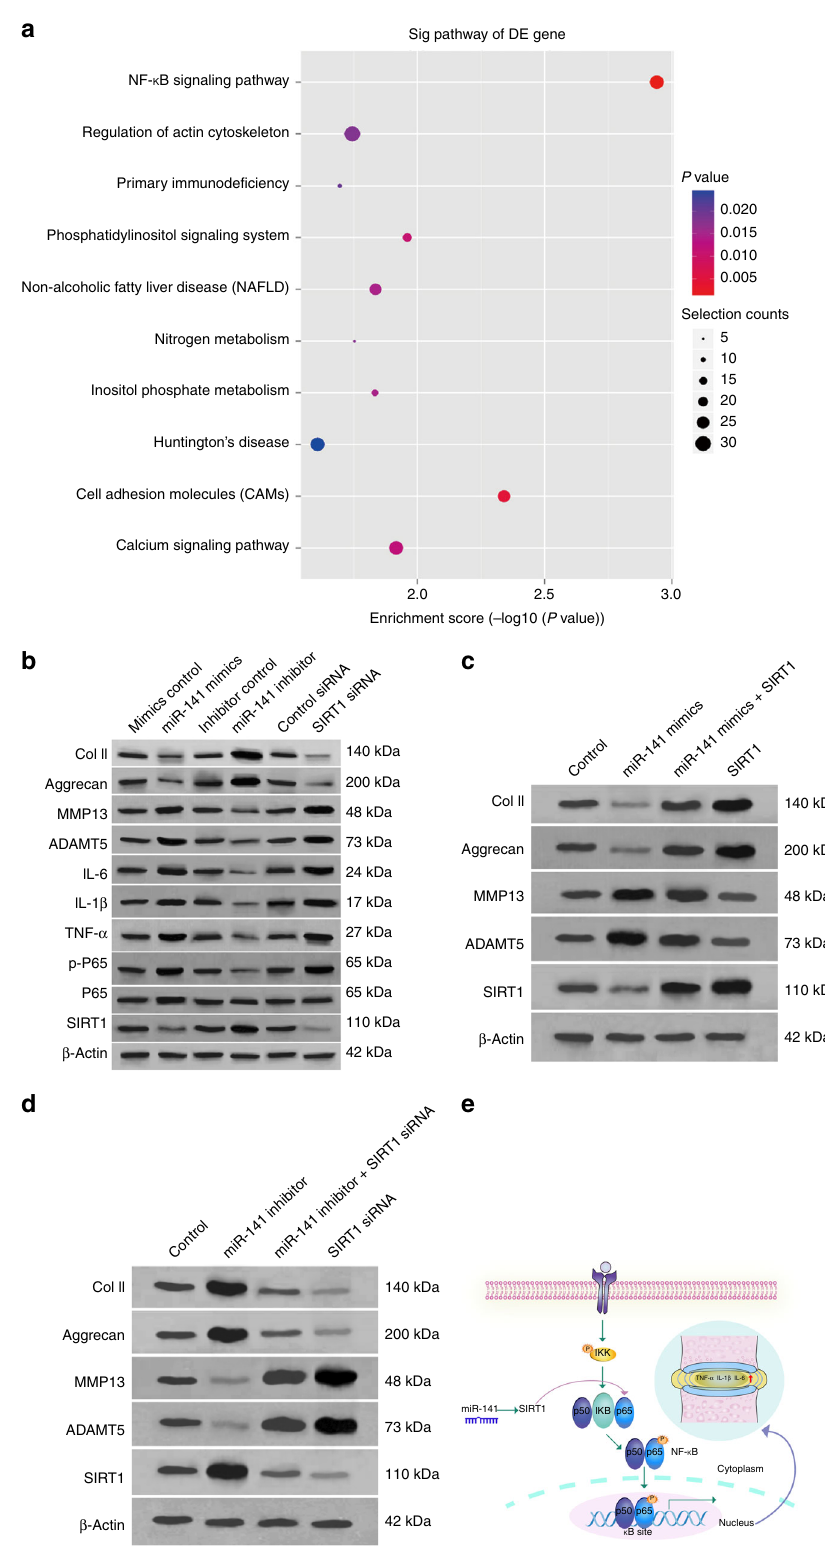
Methods Patient samples . A total of NP samples were obtained from 208 patients (59.6 ± 5.2 years) with degenerative disc disease undergoing discectomy. The surgical indications were as follows: (1) failed conservative treatment and (2) progressive neurologic de fi cits, such as progressive motor weakness or cauda equine syndrome.